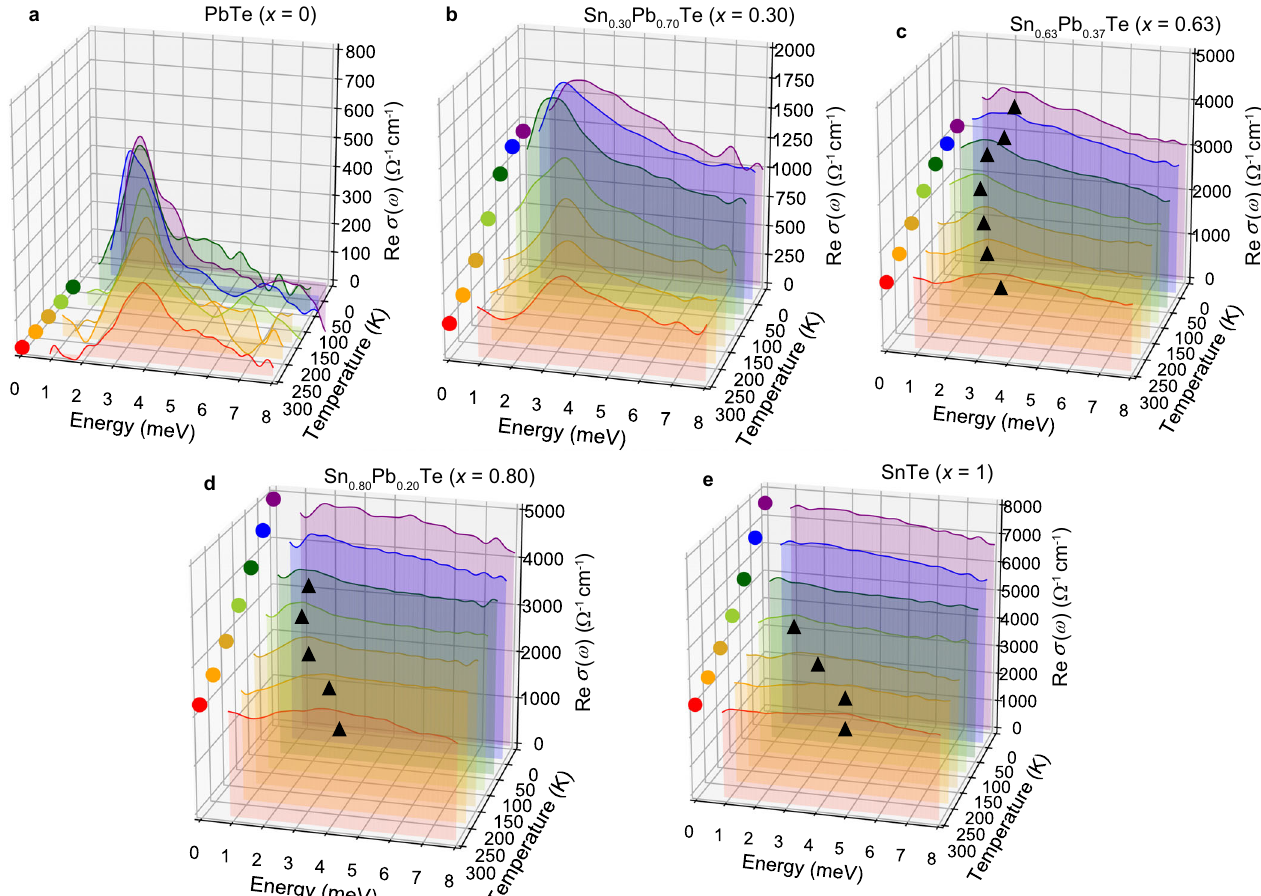
Fig. 2 Terahertz conductivity spectra of Sn x Pb 1 − x Te thin fi lms. a – e Temperature dependence of the real part of the optical conductivity spectra Re σ ( ω ) for Sn x Pb 1 − x Te ( x = 0, 0.30, 0.63, 0.80, 1). The fi lled circles in zero-energy planes represent the DC conductivity obtained from the transport measurement. The data at 5 K (purple), 50 K (blue), 100 K (green), 150 K (yellow green), 200 K (ocher), 250 K (orange) and 300 K (red) are plotted. In ( c – e ), the phonon excitations are indicated by black triangles for